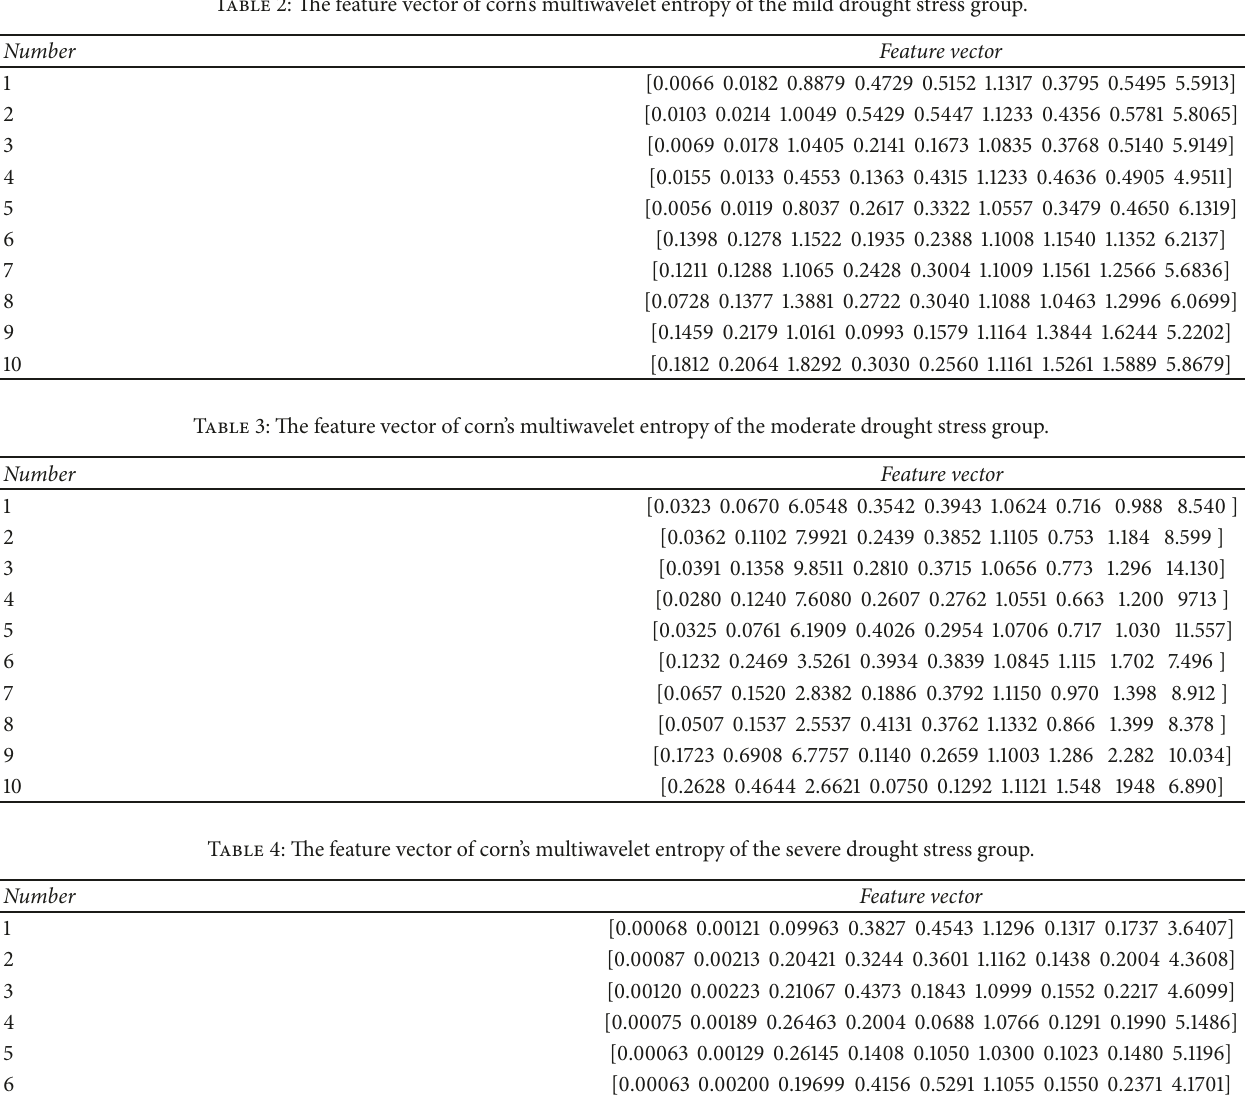
Table 2: The feature vector of corn’s multiwavelet entropy of the mild drought stress group.